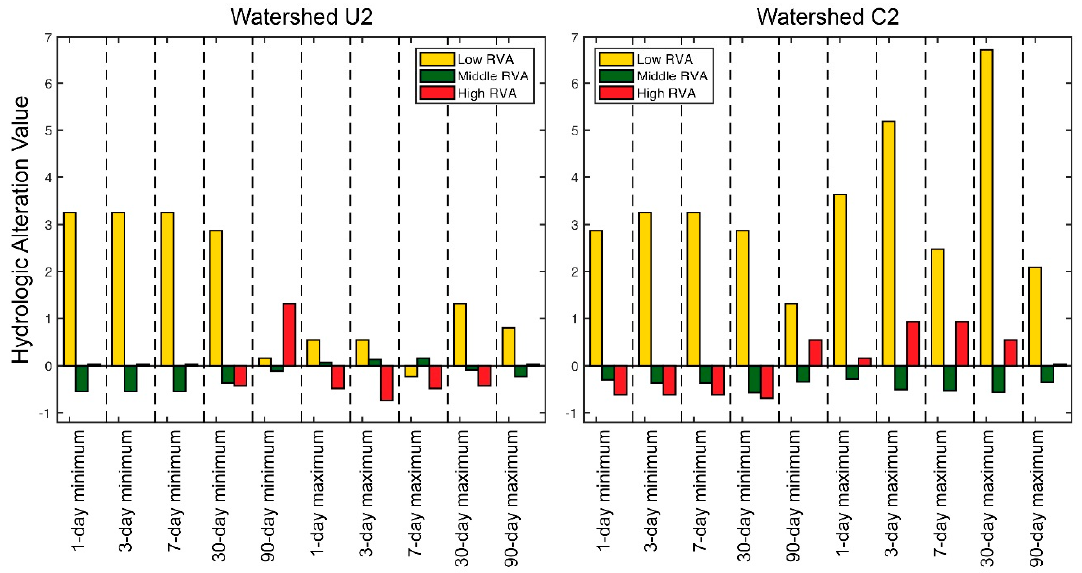
Figure 2. Range of variability approach (RVA) analysis by watershed. Positive hydrologic alteration values indicate a higher frequency of values in the given range of variability (low, middle, or high) after urbanization while negative values indicate a decreasing frequency.